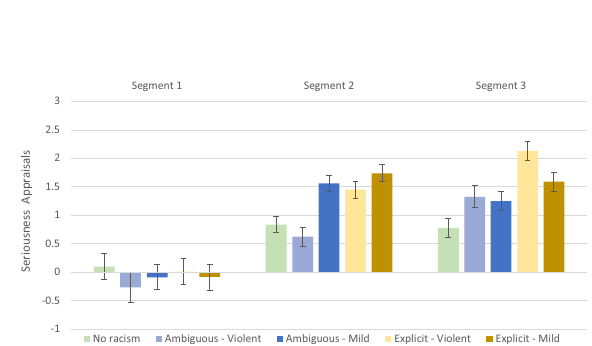
Moment-to-moment distress ratings (0 – 10) Baseline cortisol measures were taken, and then participants in all fi ve conditions watched a local news programme featuring a Black male interviewee. In the fi rst segment, in all conditions the interviewee described mild everyday workplace stressors that anyone might encounter; such innocuous events continued to be described in all three segments in the No Racism condition. The second segment introduced mild racism that was ambiguous or explicit. The third video segment presented two ambiguous conditions (mild vs. an event involving physical violence) and two explicit racism conditions(involvingthesameactionsastheambiguousconditions,buttheintervieweewasexplicitlytargetedduetorace).Throughoutthevideos,usingahand-helddevicesynchronizedtothevideo, participants provided moment-to-moment ratings (from 0 to 10) of their distress associated with the events described; these ratings were averaged within each of the three segments to provide three indices of distress. Appraisals of whether the events were discriminatory and the seriousness of their impact on the interviewee were taken following each of the three video segments, and at the end, ratings of self-reported anger were taken and two saliva samples collected.